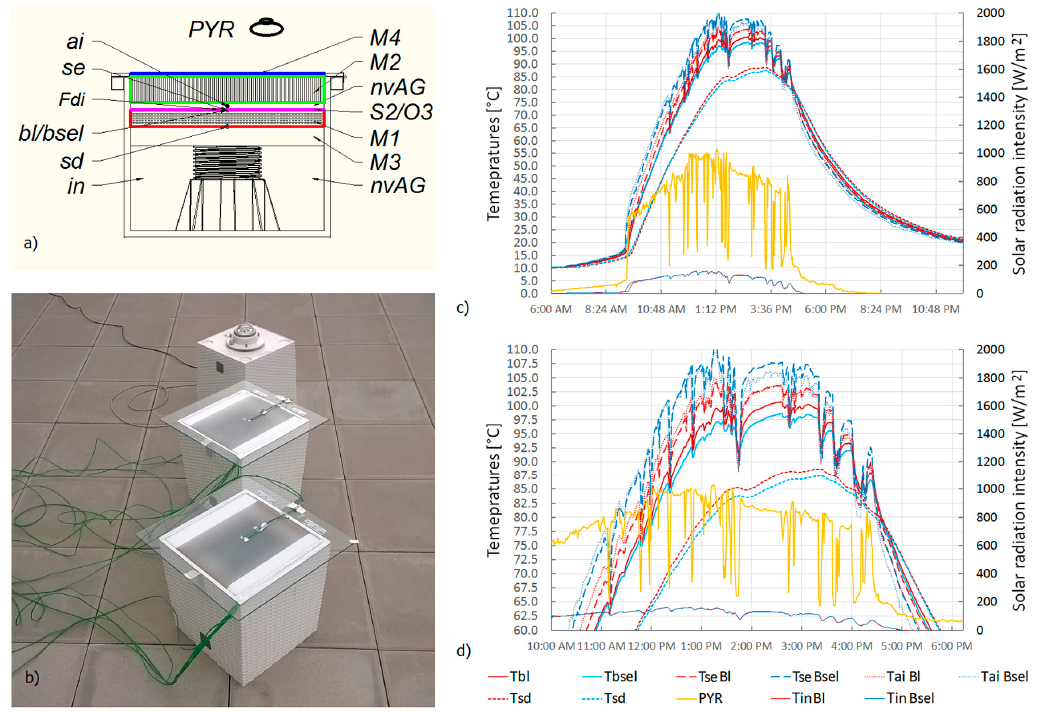
Figure 9. Small-scale outdoor measurements ( a ) Test scheme and measurement points; ( b ) Test setup; ( c ) Whole day measured temperatures; behind absorber temperatures; surface and air cavity temperatures; ( d ) Selected maximum peak temperatures of monitored day.